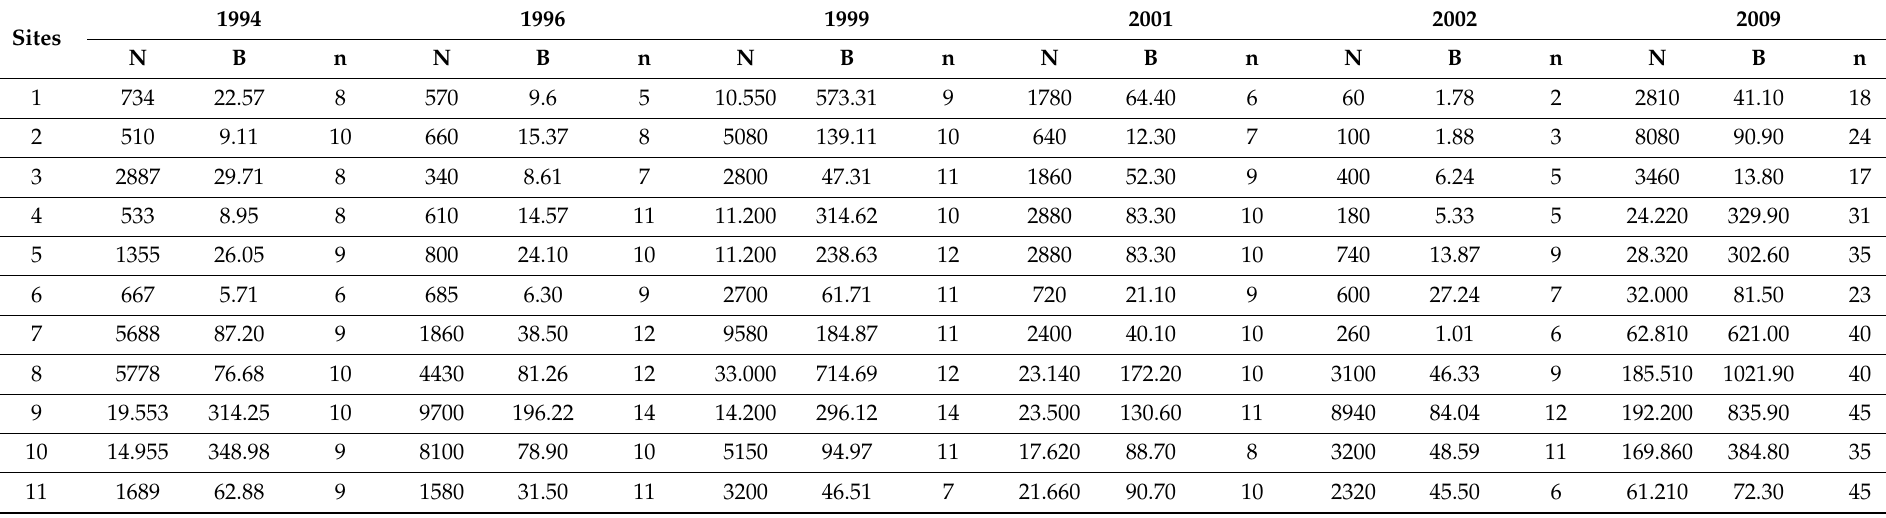
Table 3. Abundance (N, ind./m 3 ), biomass (B, mg/m 3 ) and number of zooplankton species (n) in various sites of the Ob River (sites numbers correspond to those specified in Table